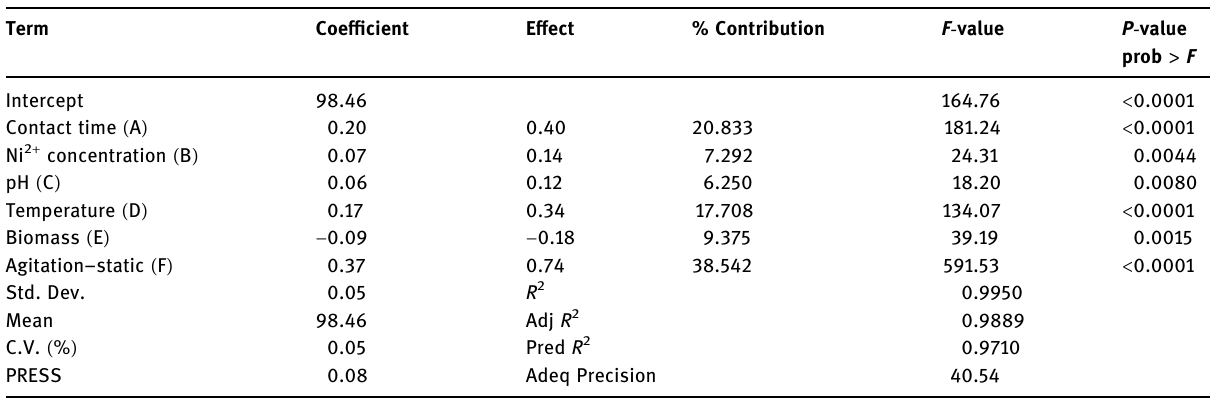
Table 2: Regression statistics and ANOVA for the experimental results of the Plackett – Burman design used for Ni 2 + biosorption by G. amansii biomass